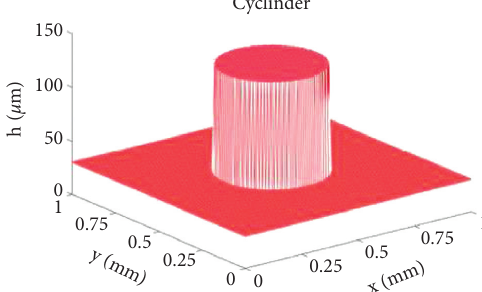
Figure 3: Cylinder texture oil film gain diagram.